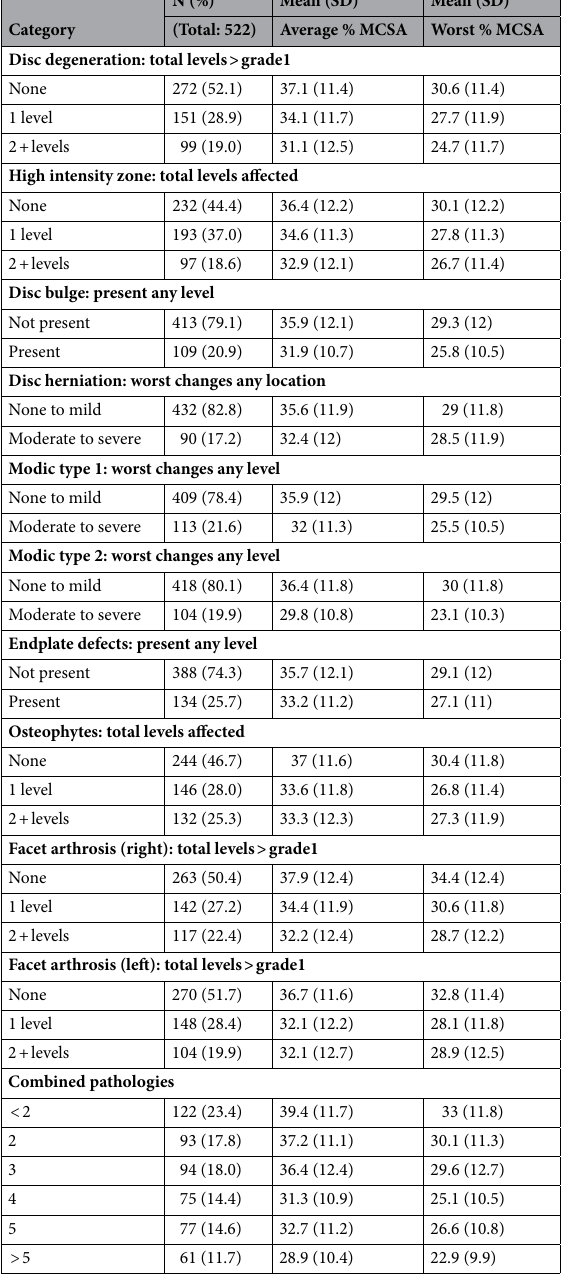
Table 3. Descriptive summary of average and worst % MCSA (L4, L5) stratified by spinal pathology categories. % MCSA, proportion of peak muscle cross-sectional area; SD, standard